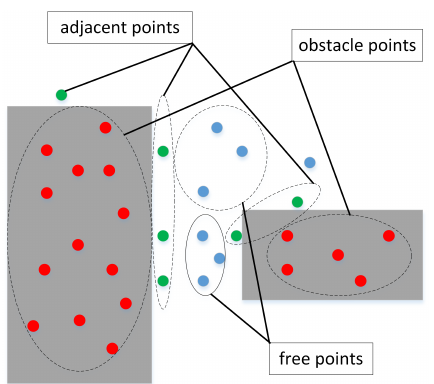
Figure 7. Optimized classification of sampling